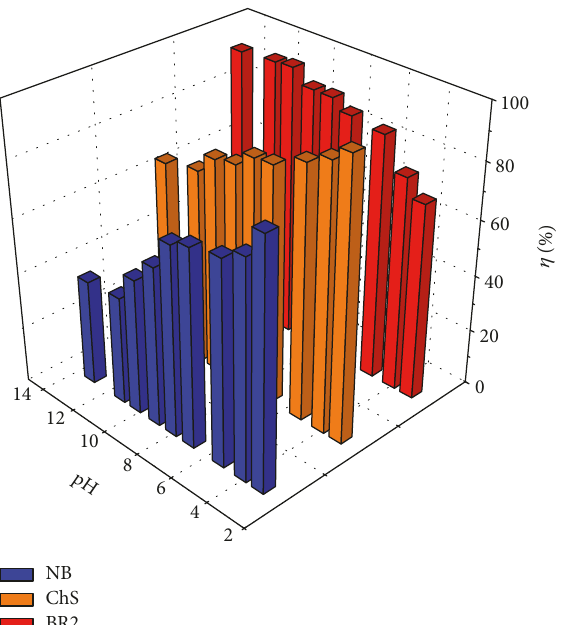
Figure 4: Effect of pH on dyes adsorption onto PM-4 adsorbent: contact time 120min, initial concentration 100mg L −1 , 1g L −1 , and 25 ∘ C.